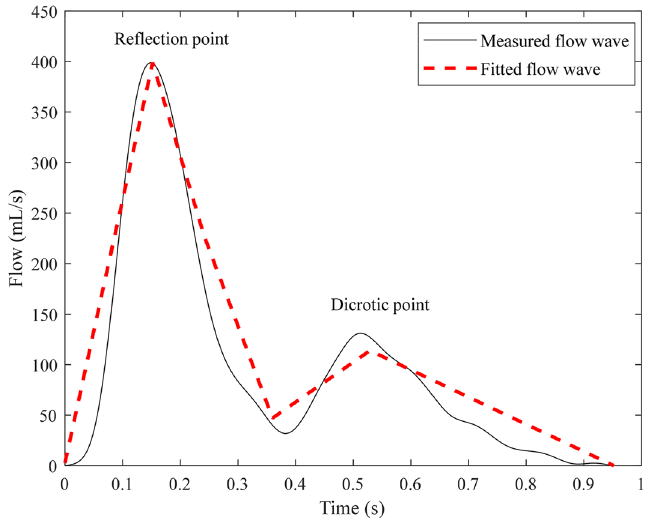
Figure 2. Calculated and measured blood flow waves.